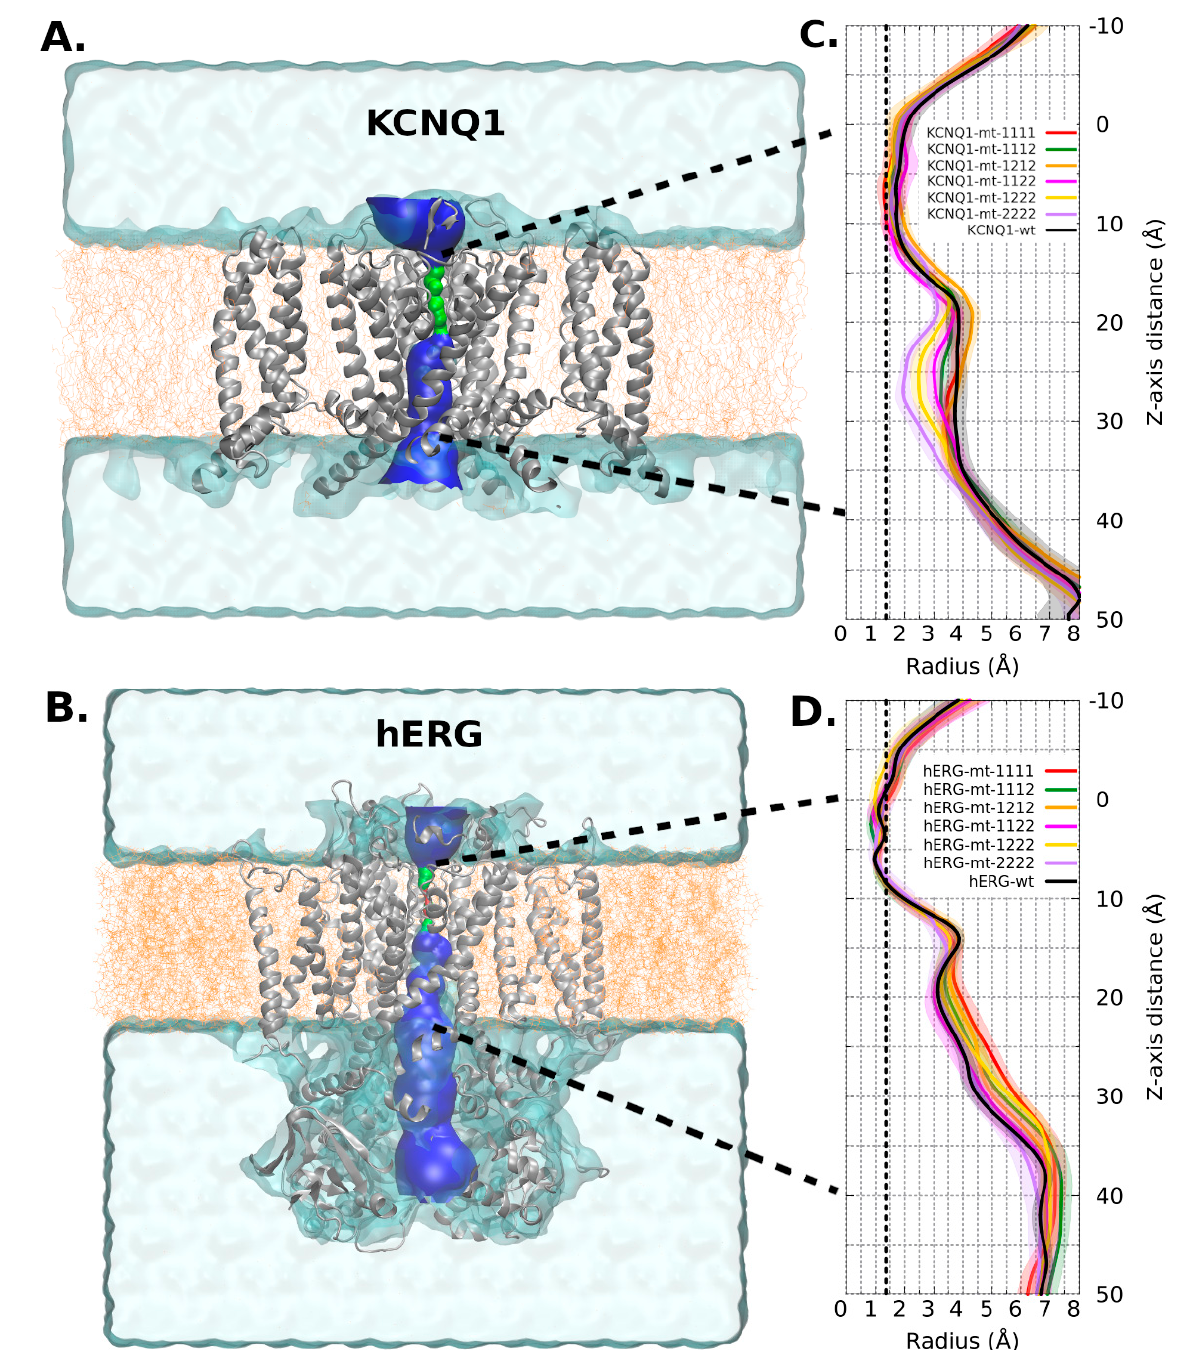
Figure 5. Membrane location, pore location, and cross section radii curve. ( A , B ): Membrane (orange) and solvent location (cyan surface region). Pore region: green surface shows region with one water molecule access and blue surface shows region with >2 water molecule access. ( C , D ): Cross section radii curves. Each series corresponds to 4 replicas, then it shows its average and standard deviation (as shaded area). The positive values of the Z-axis correspond to the inner side of the membrane. The vertical dotted line at 1.38 Å indicates the ionic radius of a K + ion. Cross section raddi curves, corresponding to the limits depicted by bold dotted lines in A and B. The transmembrane pore comprises 0 to 40 Å.